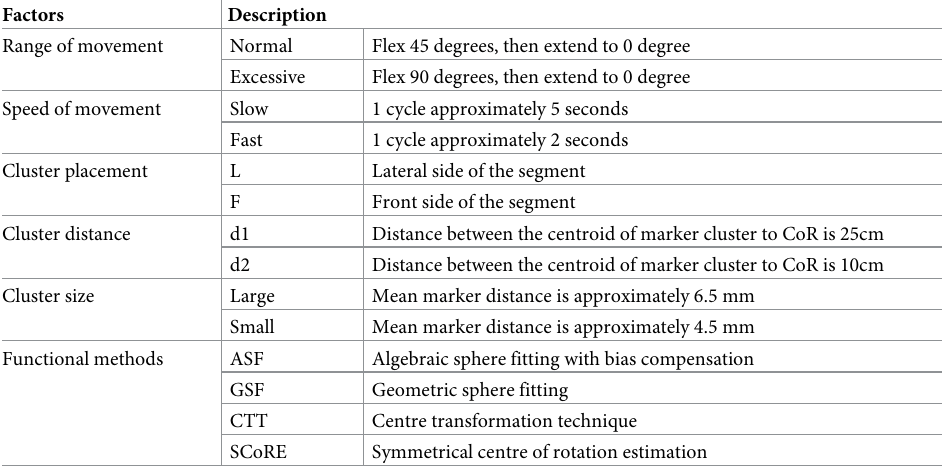
Table 1. Description of experimental and analysis